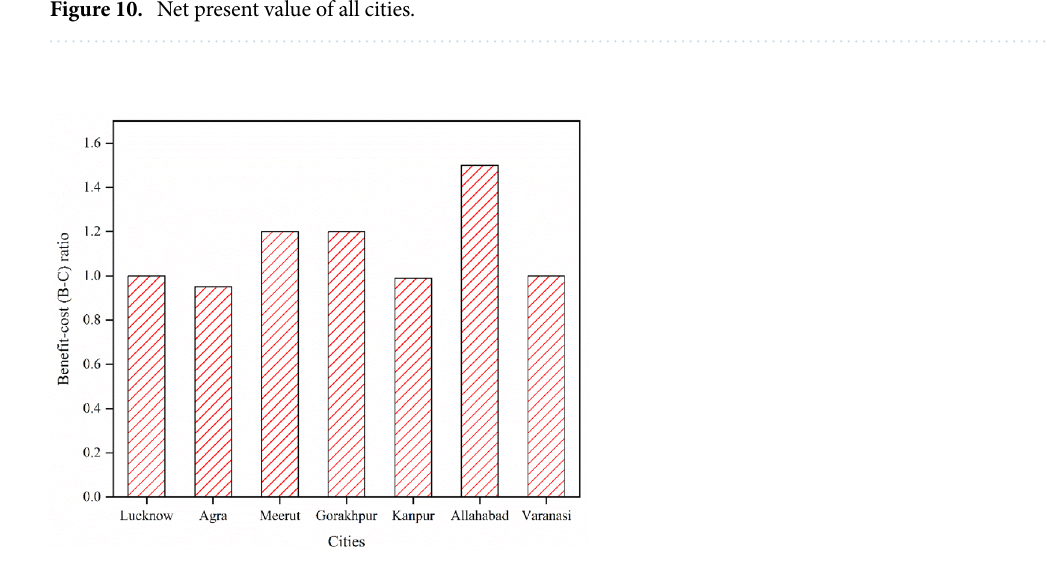
Figure 10. Net present value of all cities.